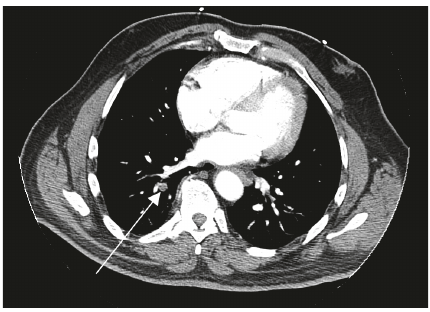
Figure 2: High-resolution CT scan of the thorax with intravenous contrastonday2: thewhitearrowshowsrightlowerlobepulmonary